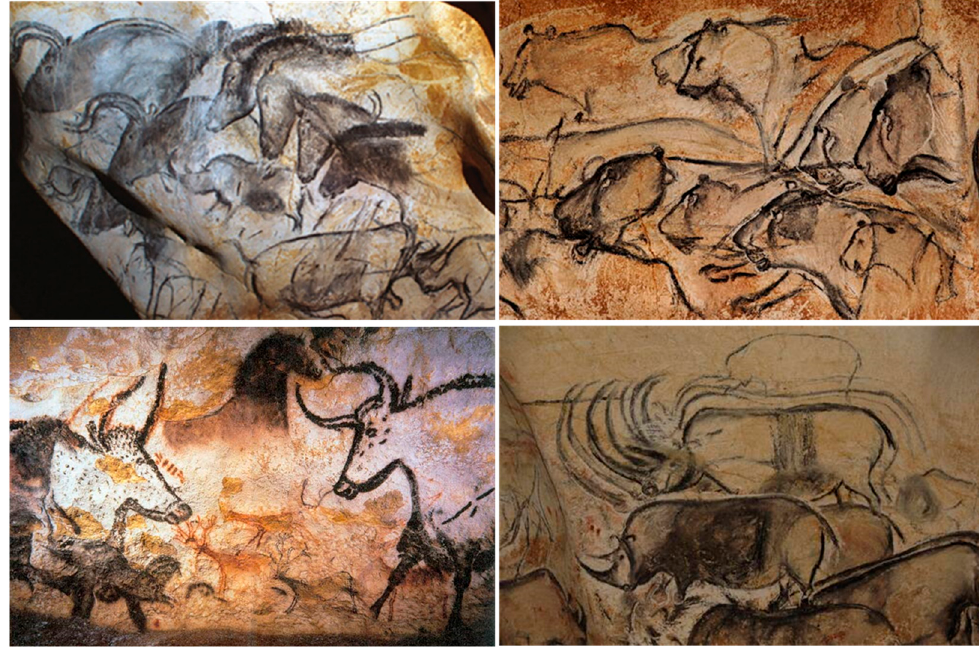
Figure 2. Ancient Paintings in Chauvet-Pont-d’Arc and Lascaux caves containing nanostructures. © MCC/DRAC. Open Access.